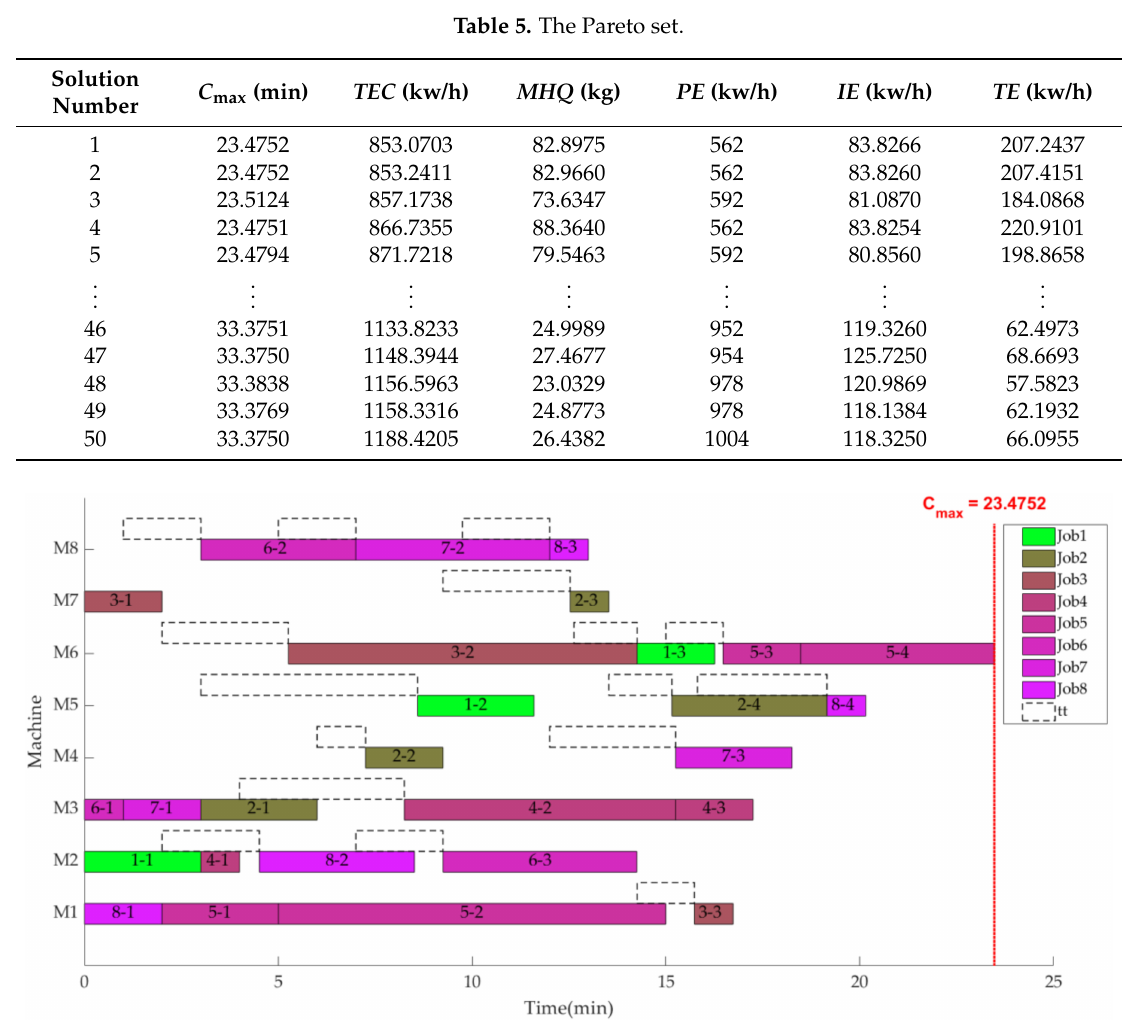
Figure 14. The Gantt chart of solution